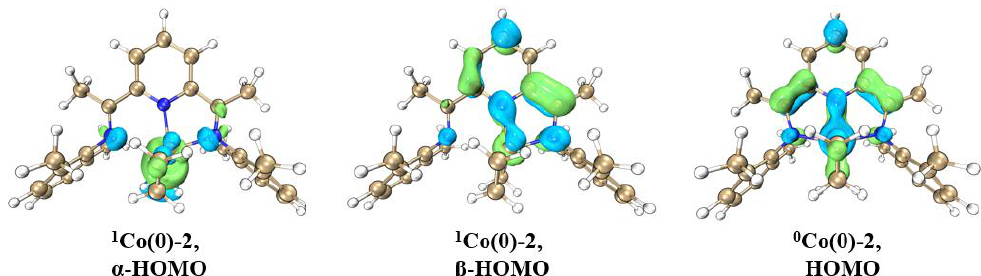
Figure 3. HUMO orbitals of 1 Co(0)-2 and 0 Co(0)-2 (green; positive orbital phase and blue; negative orbital phase, isovalue of orbital is 0.05).